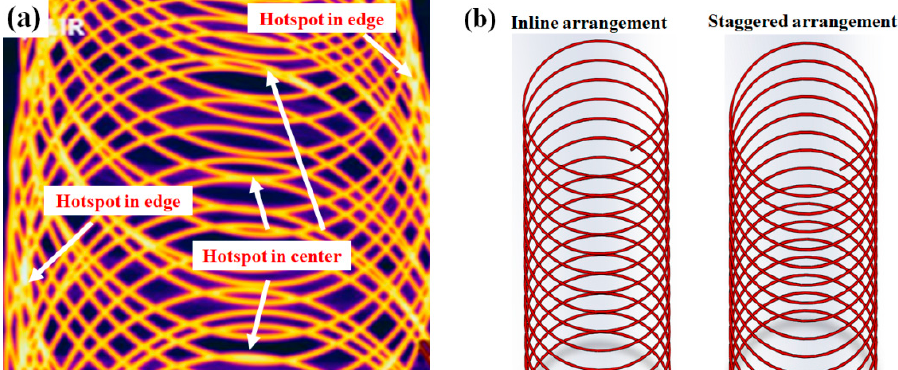
Figure 6. ( a ) Thermal image using the thermocamera in a wire rod mill and ( b ) schematic of two types of ring configuration on the conveyor roller during Stelmor cooling.